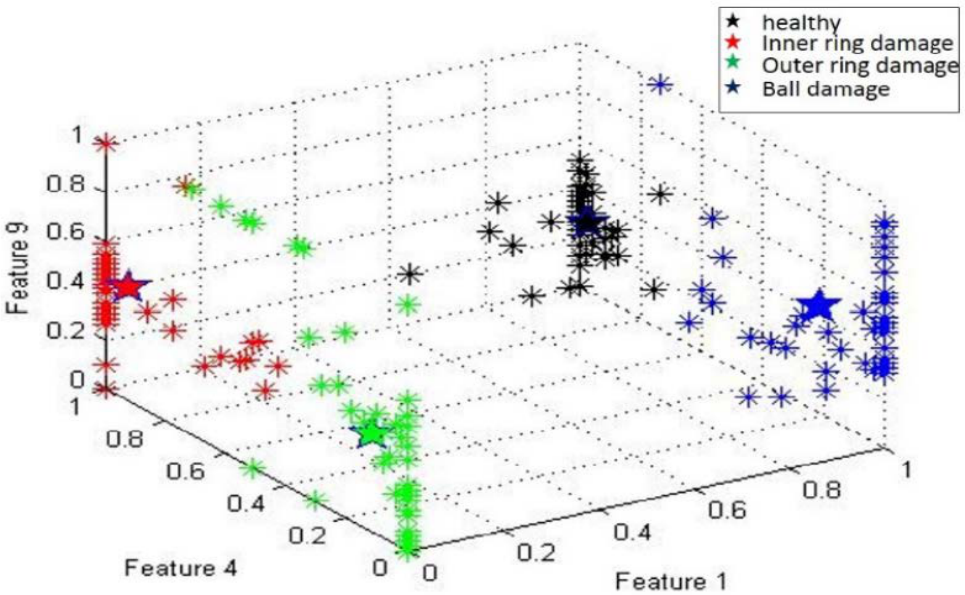
Figure 40. The 3D plot of the clustering algorithm for the diagnosis of different bearing faults. Re- produced with permission of [109].